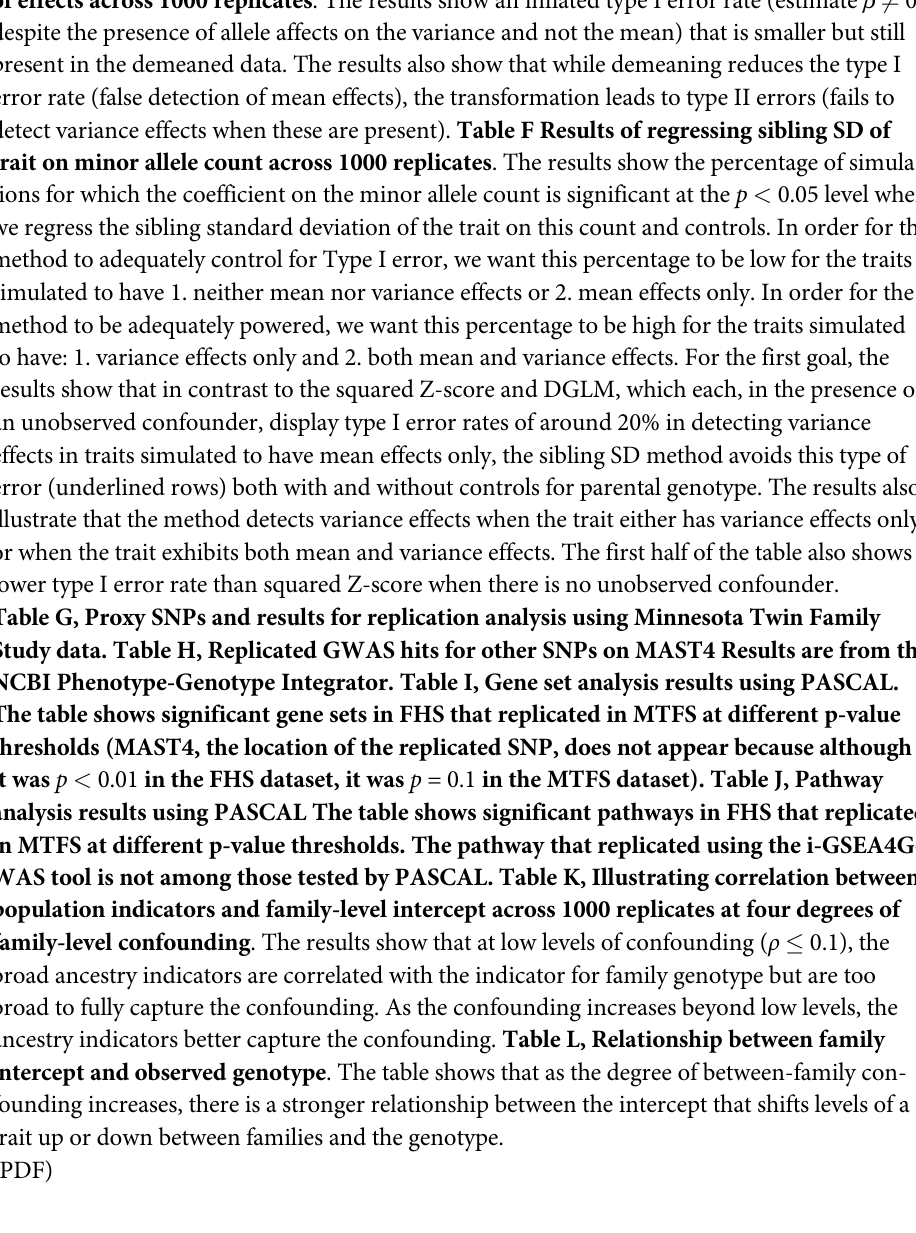
Table G, Proxy SNPs and results for replication analysis using Minnesota Twin Family Study data. Table H, Replicated GWAS hits for other SNPs on MAST4 Results are from the NCBI Phenotype-Genotype Integrator. Table I, Gene set analysis results using